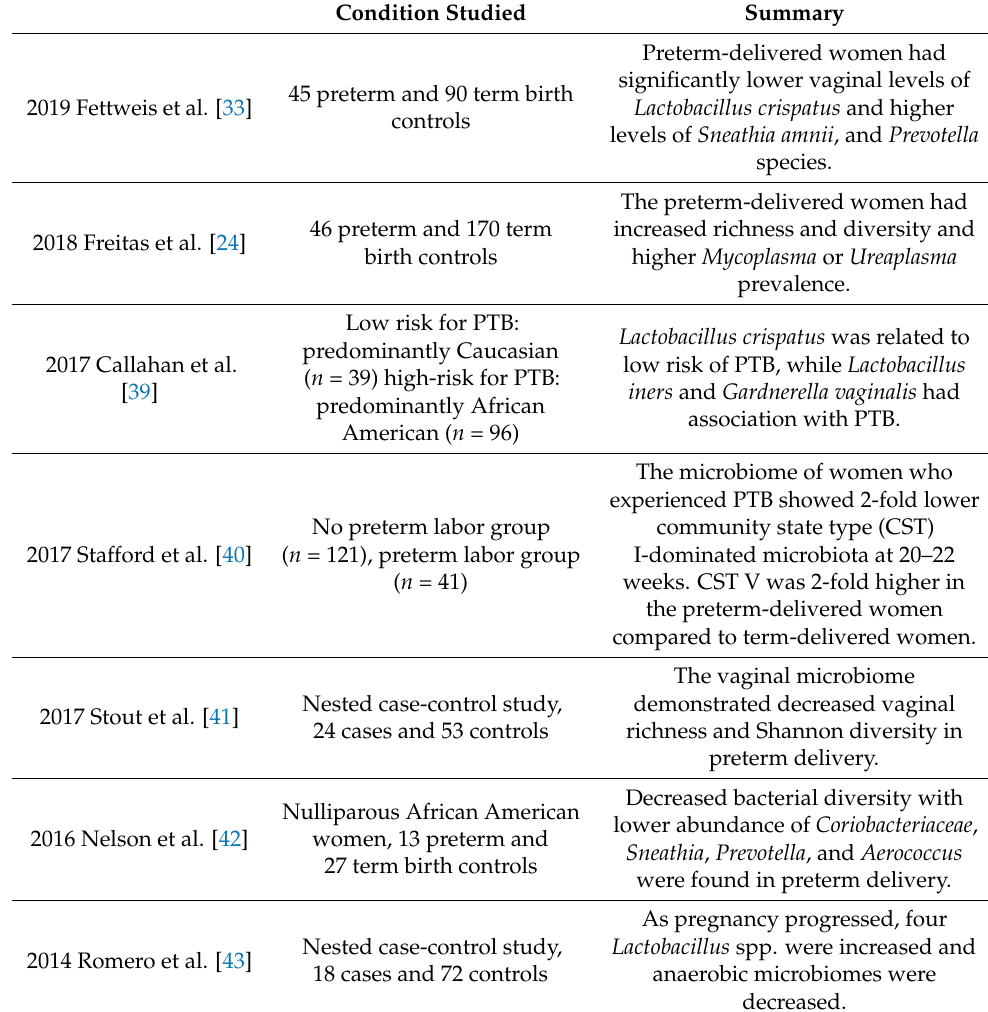
Table 3. Recent studies between Vaginal Microbiome and Preterm